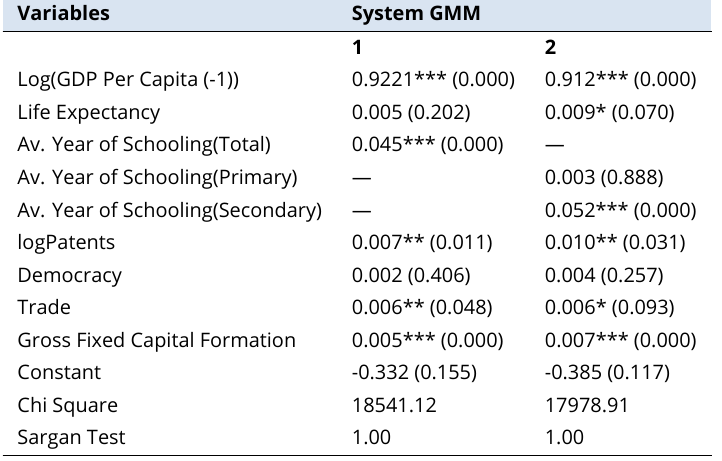
Full sample: Patents, human capital and